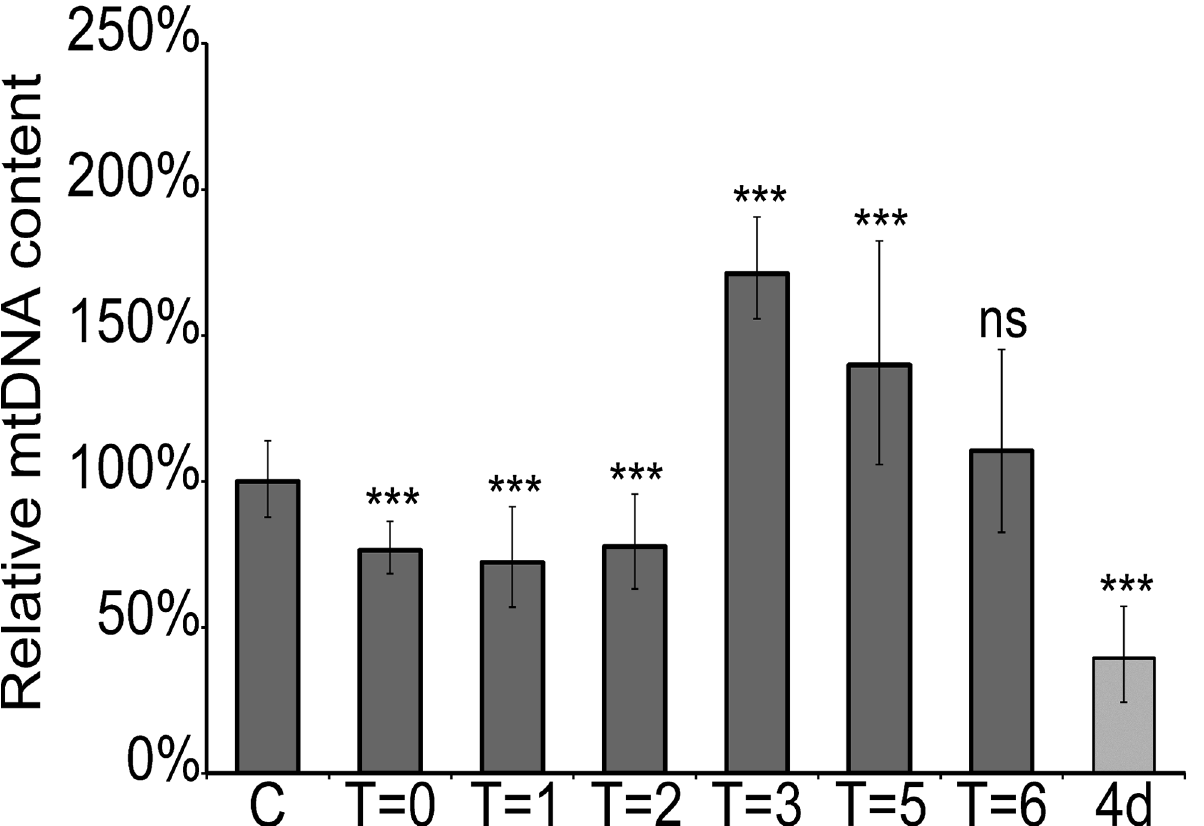
Fig 2. Recovery of mtDNA after cessation of exposure. Worms are exposed to FLT (200 μ M) from D1 of adulthood onwards for 72hrs after which they are transferred to plates without FLT. This results in a recovery of mtDNA. Error bars show the 95% C.I. (df = 16). C = untreated worms, T = #hr after transfer, 4d = 4days of continuous exposure. Significance was determined using a two-tailed student ’ s T test assuming unequal variances. *** P-value < 0.001 compared to unexposed animals. ns: not significant compared to unexposed animals.